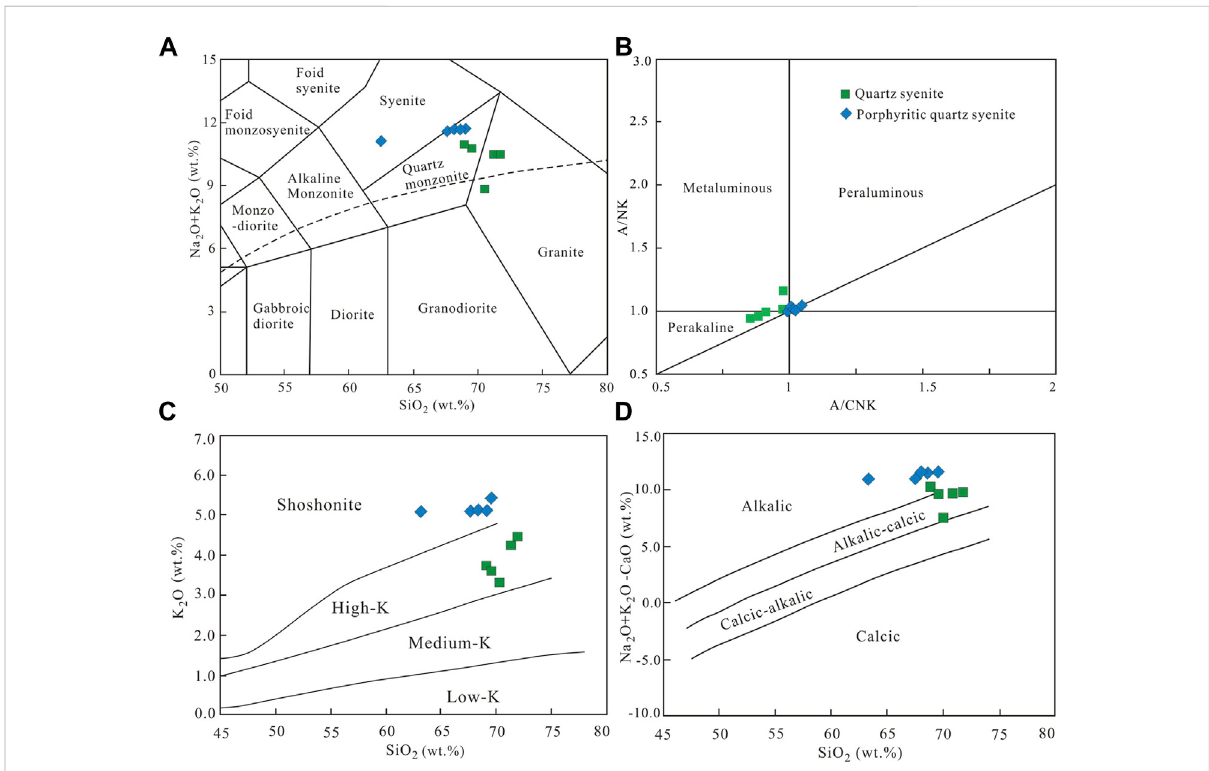
FIGURE 4 Geochemical diagrams forthe(porphyritic)quartzsyeniteanalyzedinthisstudy. (A) SiO 2 versusK 2 O(afterMiddlemost,1994.Thedottedlineof alkalineandsubalkalineseriesfromIrvineandBaragar,1971); (B) A/CNK[molarratioAl 2 O 3 /(K 2 O+Na 2 O+CaO)]versusA/NK[molarratioAl 2 O 3 /(K 2 O + Na 2 O)] (after Maniar and Piccoli, 1989); (C) SiO 2 versus K 2 O (after Peccerillo and Taylor, 1976); (D) SiO 2 versus K 2 O + Na 2 O — CaO (after Frost et al.,